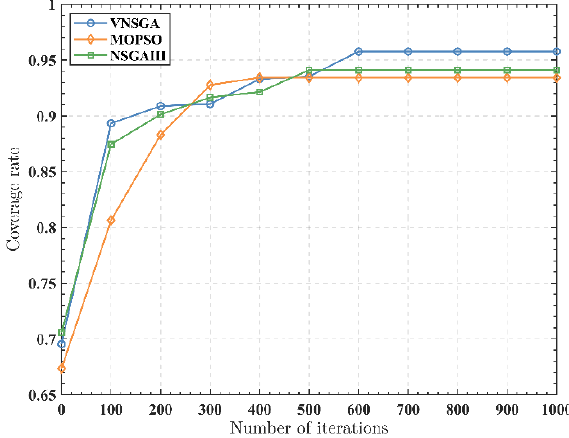
Figure 18. Coverage rate for three algorithms from different iterations for 100 m R smax and 200 m R cmax with respect to area A.